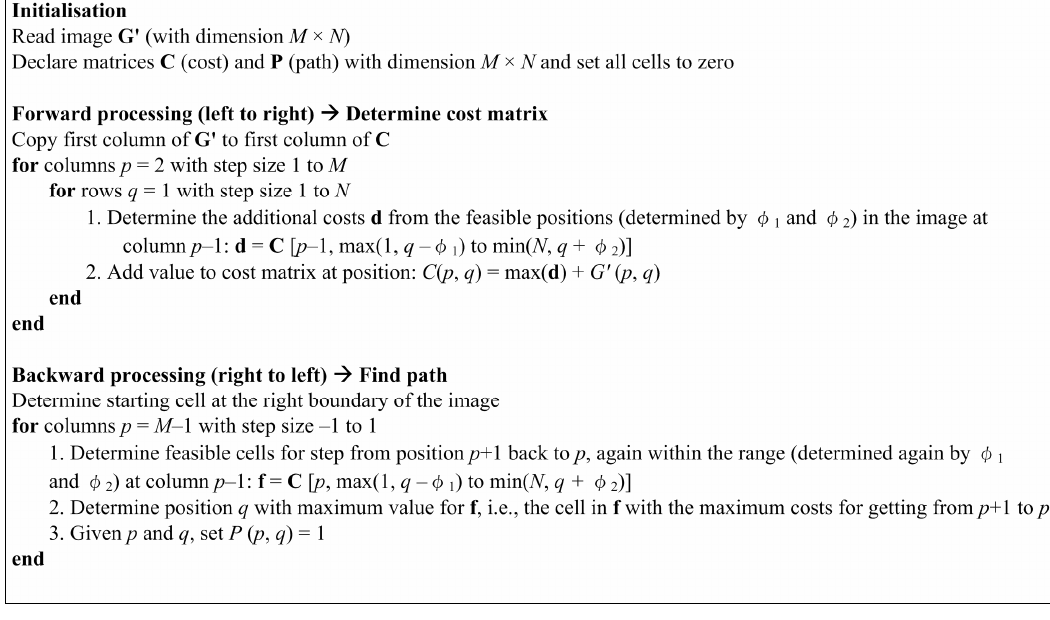
Figure 4. Pseudo code of the procedure to find the path with maximum costs in image G ¢¢¢¢ .